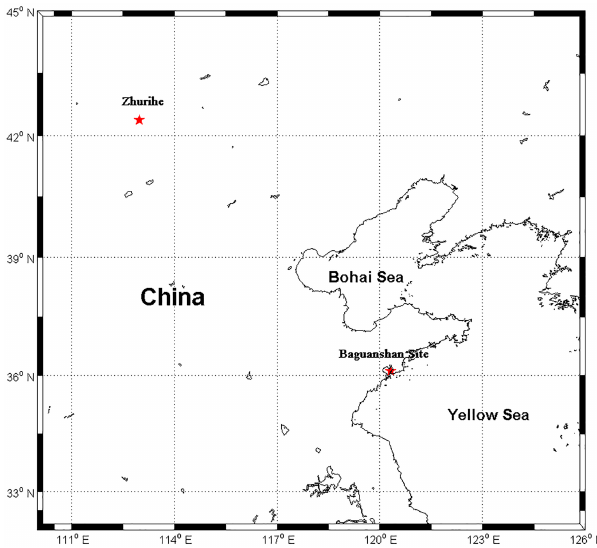
Table 2. Detection limits, precisions and recoveries of water-soluble ions and metal